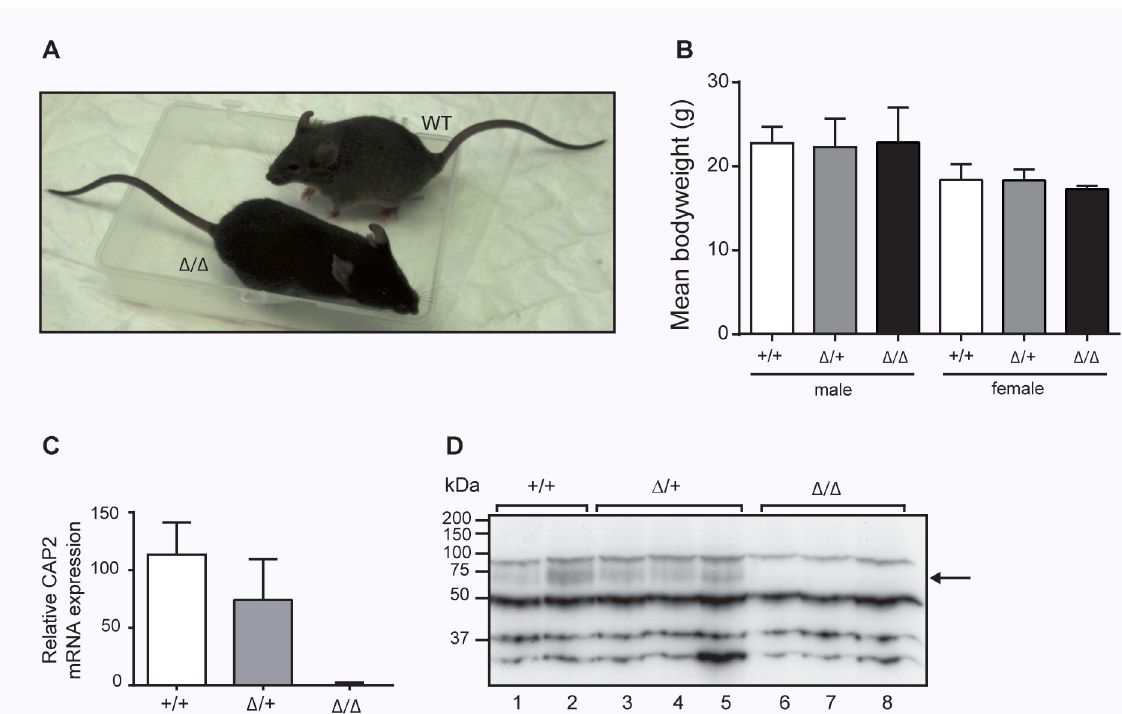
Fig 3. Phenotype of CAP2/ Tmprss4 -deficient mice. (A) Representative pictures of 3 months old (male) CAP2/ Tmprss4 wildtype (WT) and CAP2/ Tmprss4 knockout (KO) littermates. ( B ) Mean body weight (g) of 3-month-old male and female wildtype (WT, n = 6), heterozygous mutant (HET, n = 11 and n = 9, respectively), and knockout (KO, n = 6 and n = 5, respectively) mice. ( C ) Relative CAP2/ Tmprss4 mRNA transcript expression in colon from CAP2/ Tmprss4 WT , CAP2/ Tmprss4 HET and CAP2/ Tmprss4 KO mice (n = 6 mice per group); β -actin is used as internal control. ( D ) Representative immunoblot showing the presence of a 70kDa CAP2/Tmprss4-specific band in colon extracts from CAP2/ Tmprss4 WT (lane 1 and 2), CAP2/ Tmprss4 HET (lane 3 – 5) mice and absence in CAP2/ Tmprss4 KO (lane 6 – 8) mice; arrow indicates the size of the expected but absent CAP2/Tmprss4-specific band in knockouts.